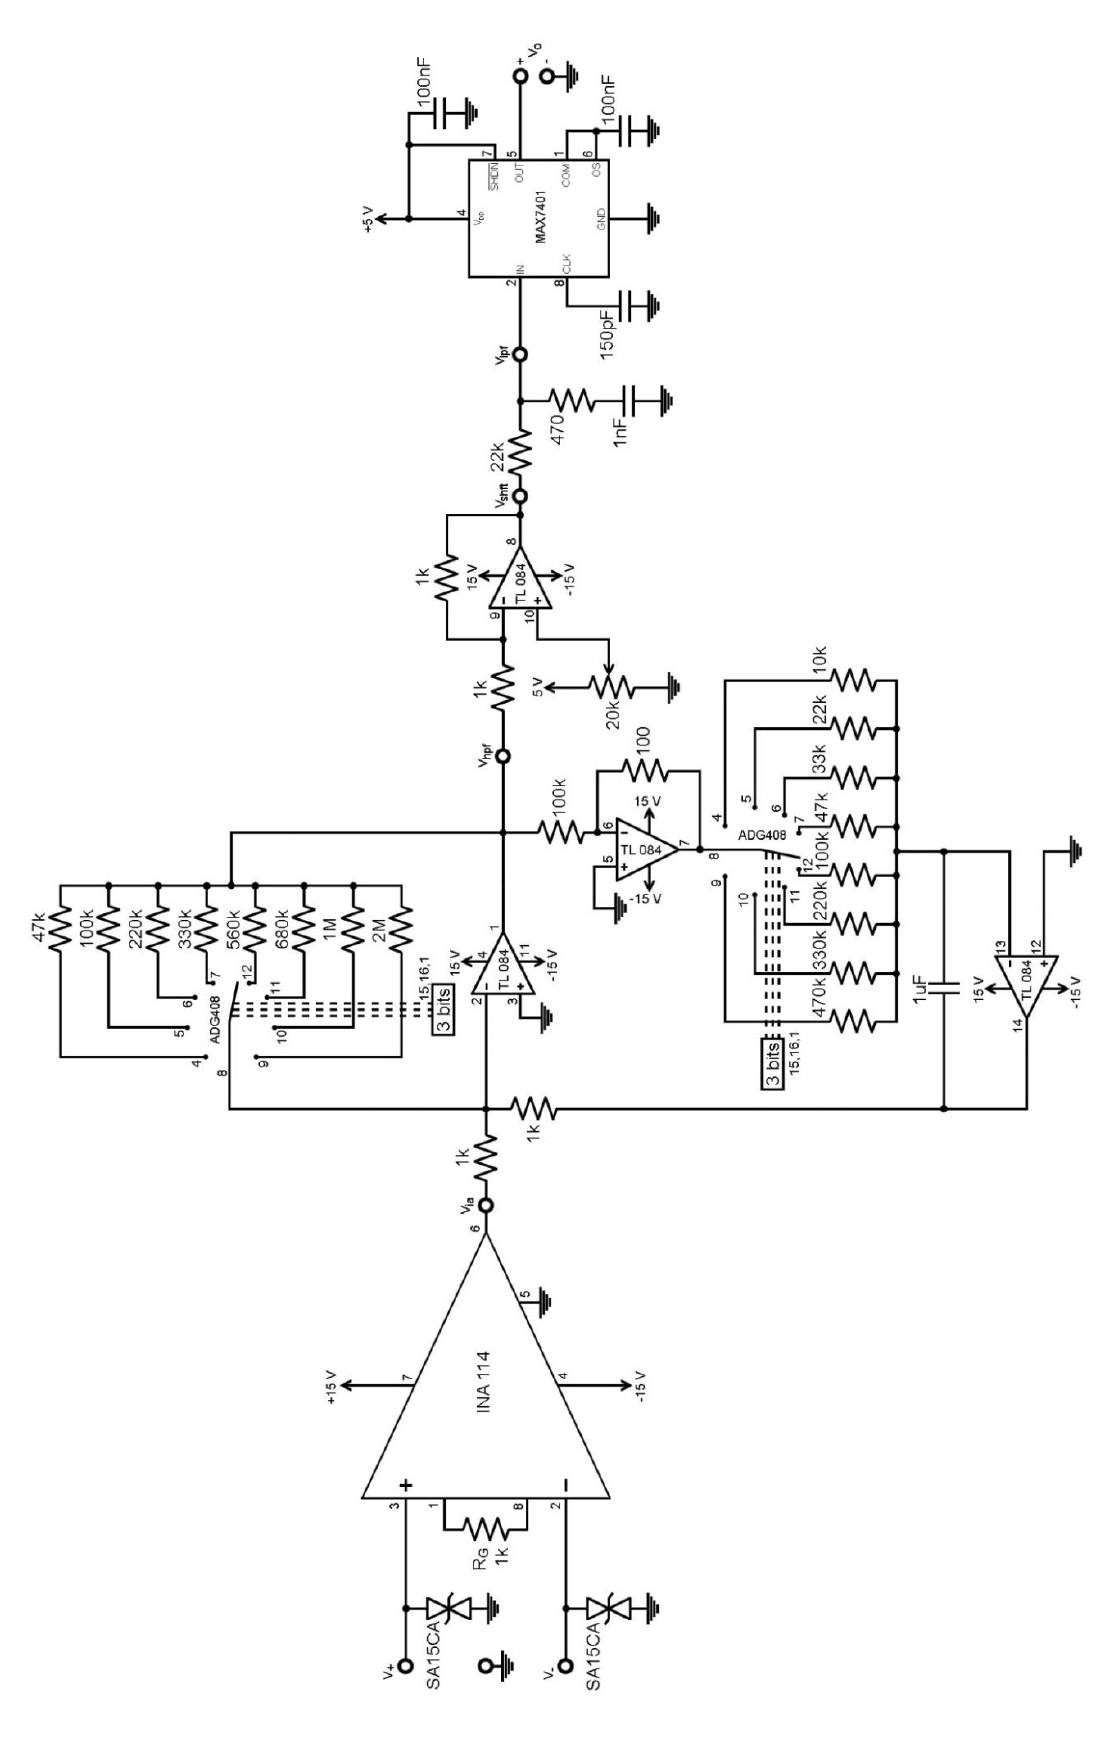
Figure 5. Test circuit for the stage in Figure